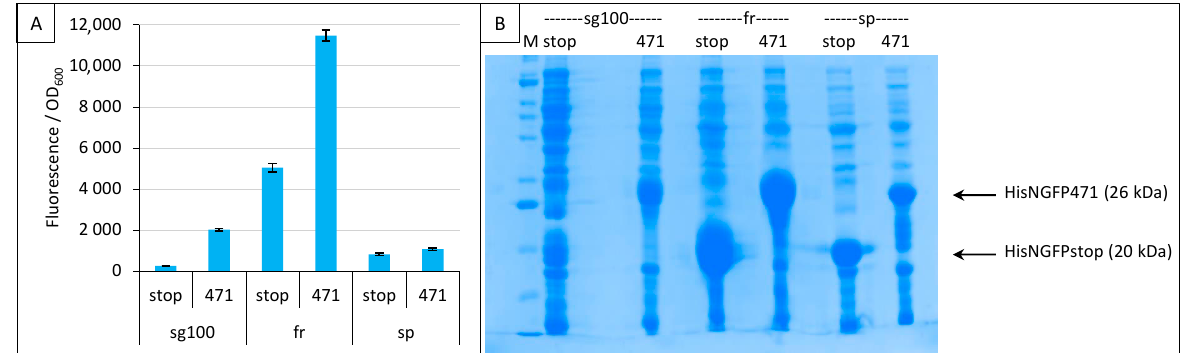
levels (Figure 3B).